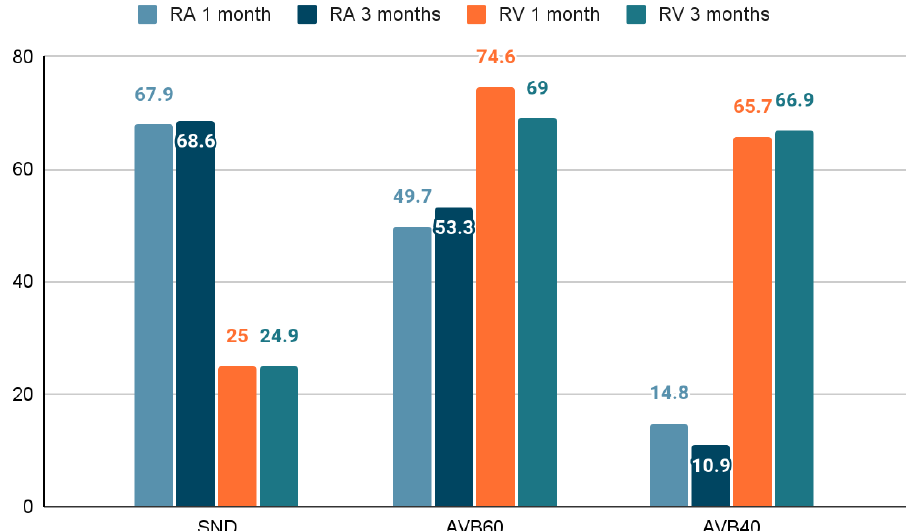
Figure 1. Pacing percentage. AVB40-atrioventricular block group with a lower rate set to 40 bpm and no rate response. AVB60-atrioventricular block group with a lower rate set to 60 bpm and no rate response. SND—Sinus node disease group with a lower rate set to 60 bpm and rate response enabled. RA—right atrium; RV—right ventricle.